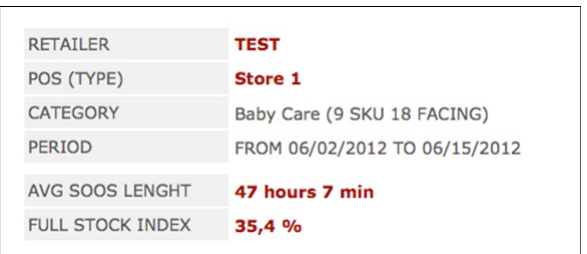
Figure 4. Particular of the report produced.